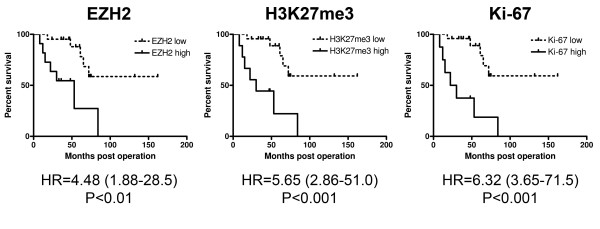
Kaplan-Meier survival curves for high vs. low EZH2, HeK27me3, and Ki-67 score. Hazard ratios (HR) of the high-score groups with 95% confidence intervals are shown at the bottom.